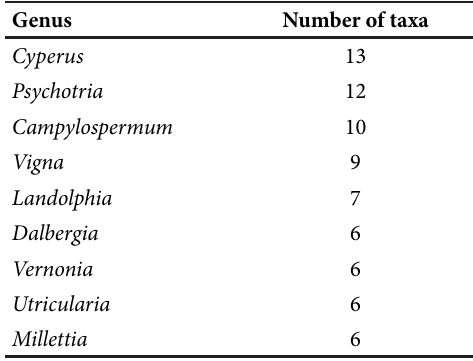
Table 2. Top ten families from the checklist with number of taxa. Family